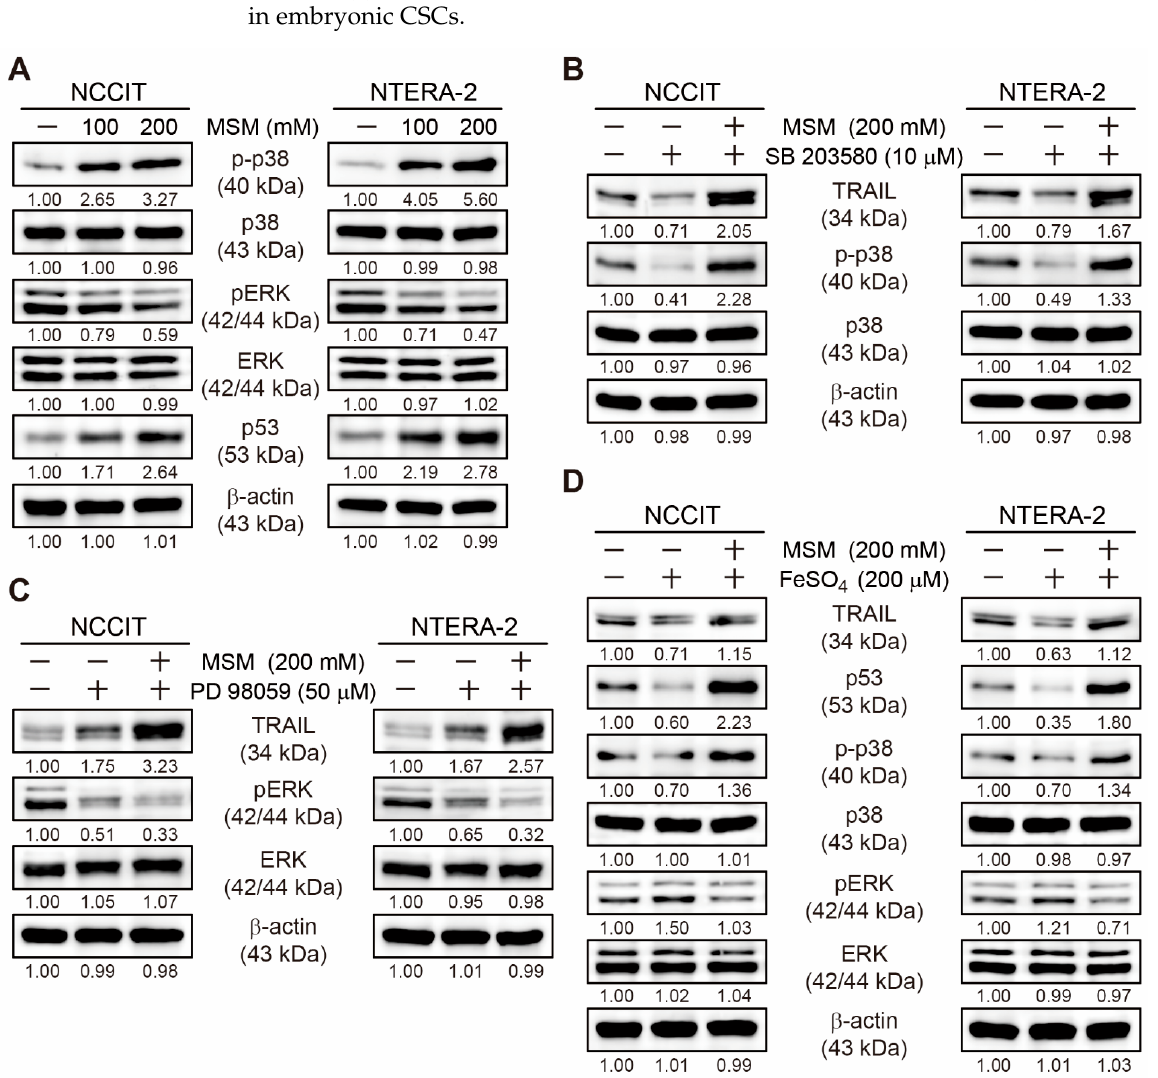
Figure 5. MSM regulated p38/ERK/p53 signaling and TRAIL expression. ( A ) Western blotting of NCCIT and NTERA-2 cells with 100 and 200 mM MSM for 48 h, showing the expression of phospho-p38, p38, phospho-ERK, ERK, and p53 proteins. Expression levels were estimated by densitometry and normalized to β -actin. Data were obtained in triplicate. ( B ) Western blotting of NCCIT and NTERA-2 cells with 10 μ M SB 203580 or 200 mM MSM for 48 h, showing the expression of TRAIL, phospho-p38, and p38 proteins. Expression levels were estimated by densitometry and normalized to β -actin. Data were obtained in triplicate. ( C ) Western blotting of NCCIT and NTERA-2 cells with 50 μ M PD 98,059 or 200 mM MSM for 48 h, showing the expression of TRAIL, phospho-ERK, and ERK proteins. Expression levels were estimated by densitometry and normalized to β -actin. Data were obtained in triplicate. ( D ) Western blotting of NCCIT and NTERA-2 cells with 200 μ M FeSO 4 or 200 mM MSM for 48 h, showing the expression of TRAIL, phospho-p38, p38, phospho-ERK, ERK, and p53 proteins. Expression levels were estimated by densitometry and normalized to β -actin. Data were obtained in triplicate.